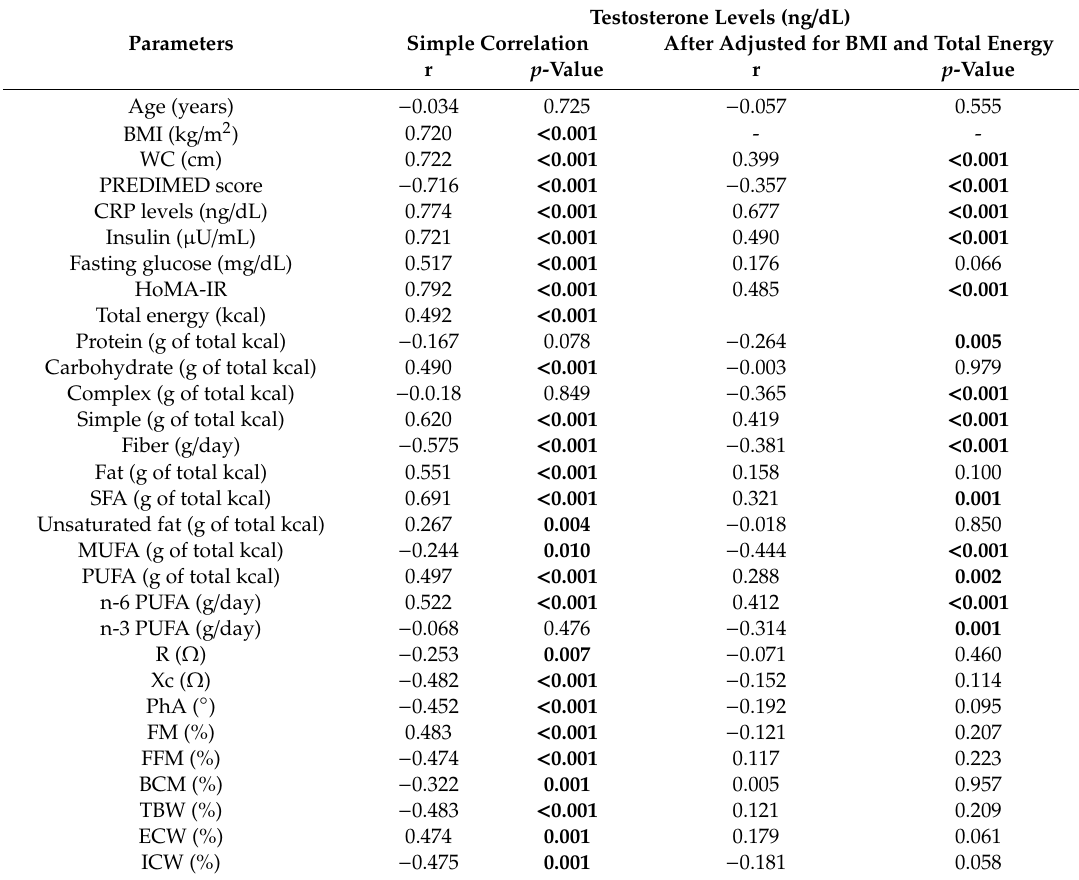
Table 5. Age, anthropometric measurements, adherence to the MD, inflammatory parameter, dietary intake and body composition of the case-patients and the control